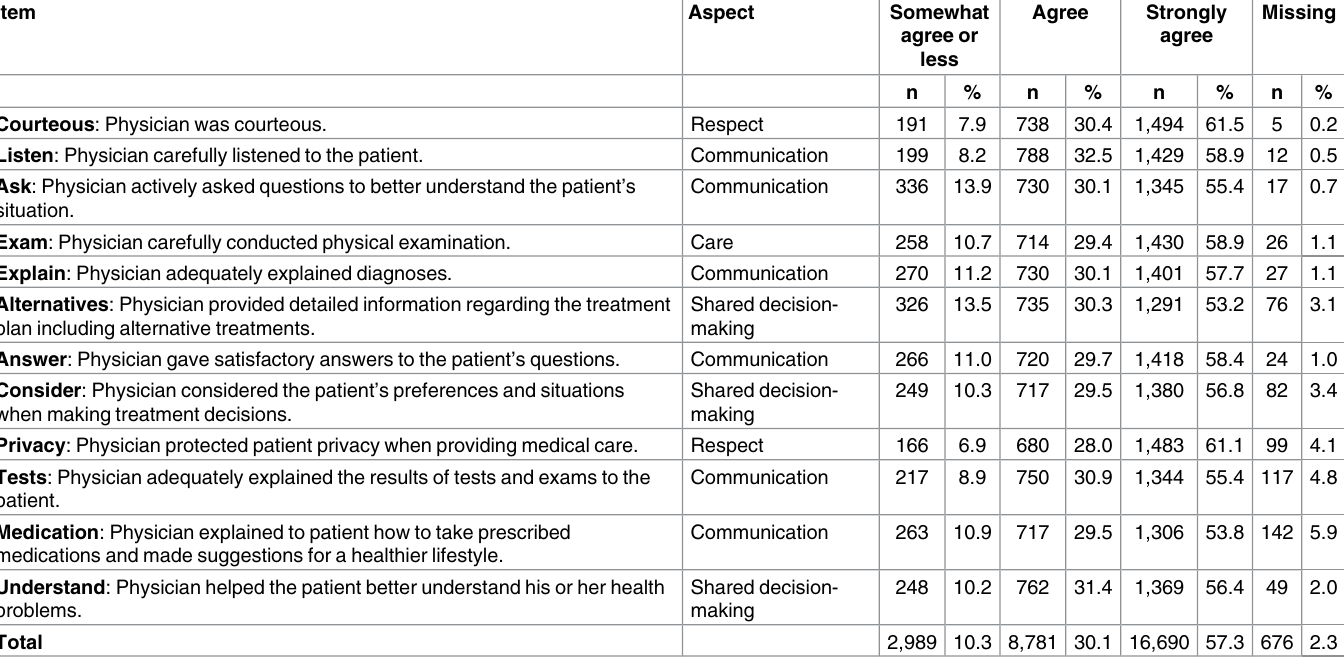
Table 2. Patient experiencewith outpatient encounters at public hospitals in Shanghai: Specialty Hospitals.